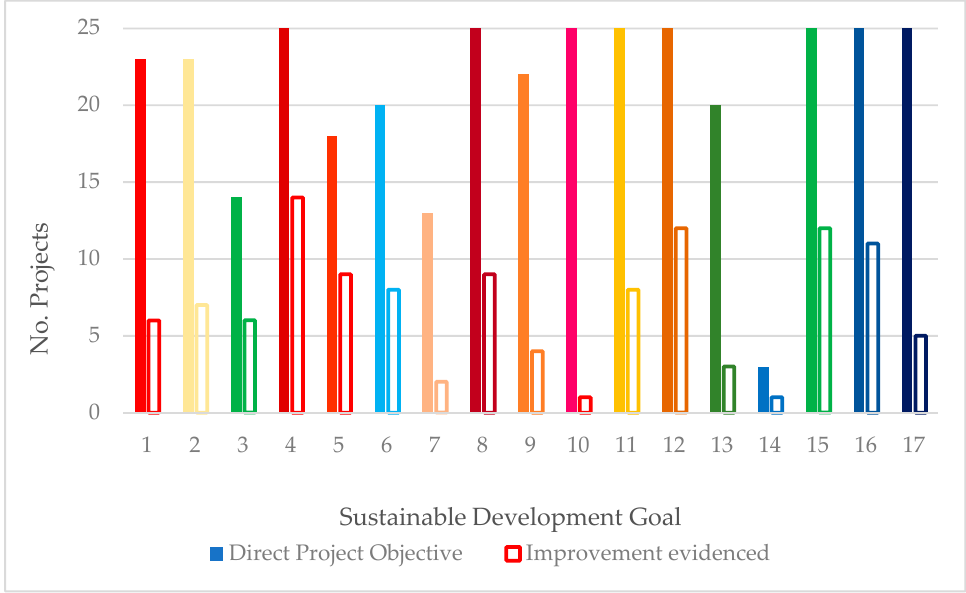
Figure 5. Numbers of REDD+ projects that target specific SDGs in their project design documents (solid boxes), compared to the number of projects reporting improvement (=impact score 3; unfilled boxes) based on project implementation reports. Colors mimic those that are used for SDG icons [16].